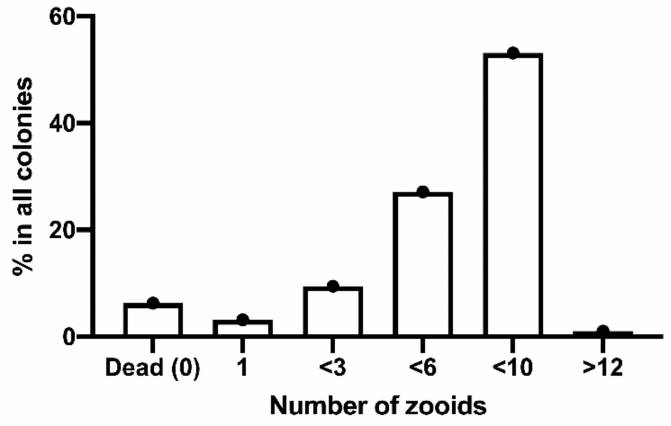
Figure 5. Percentage of colonies of Botryllus shlosseri containing different numbers of blastozooids at the fourth week after settlement.